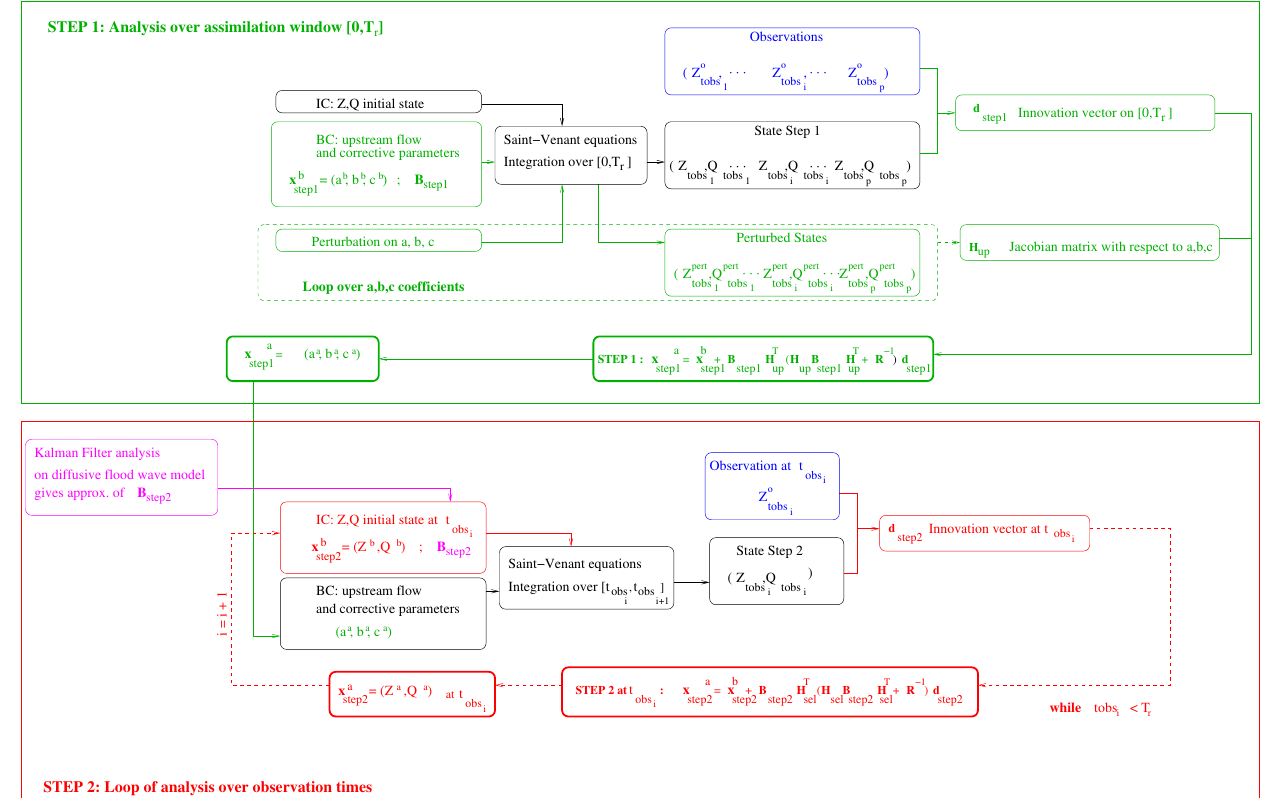
Fig. 1. Two-step data assimilation procedure flowchart on the time window [ 0 ,T r ] .